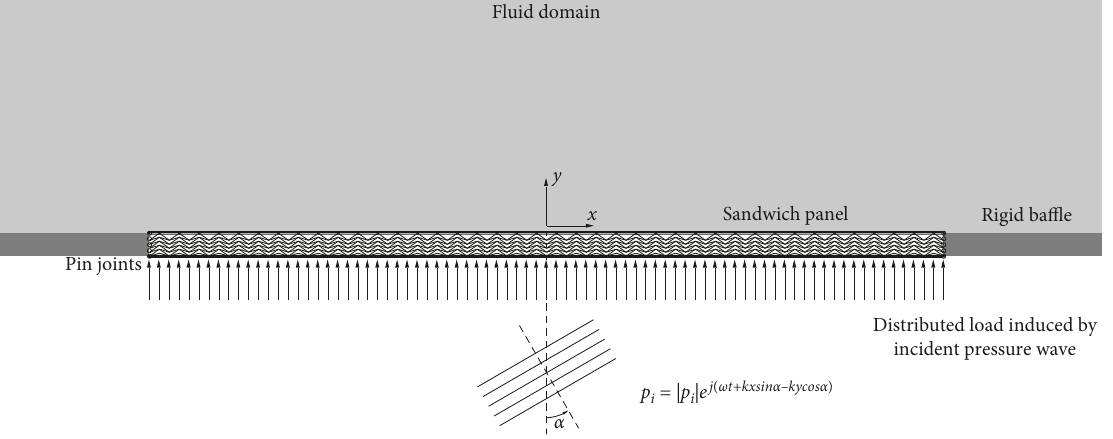
Figure 6: Acoustic loading and boundary conditions for a baffled, simply supported sandwich panel with a DAH